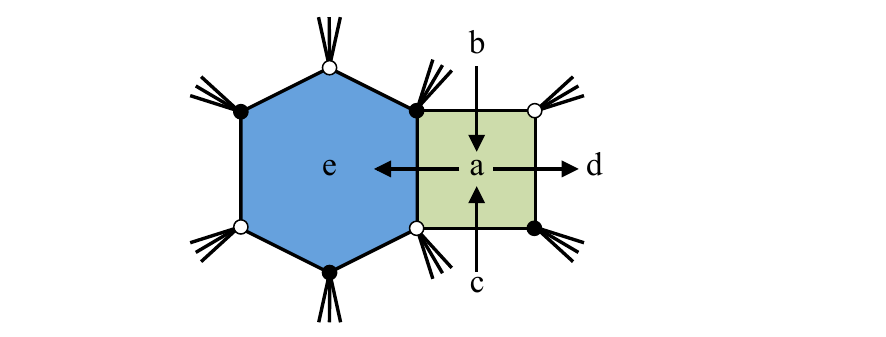
Figure 43. Local con(cid:12)guration showing a face to be Seiberg dualized (green) which is adjacent to a D-brane instanton